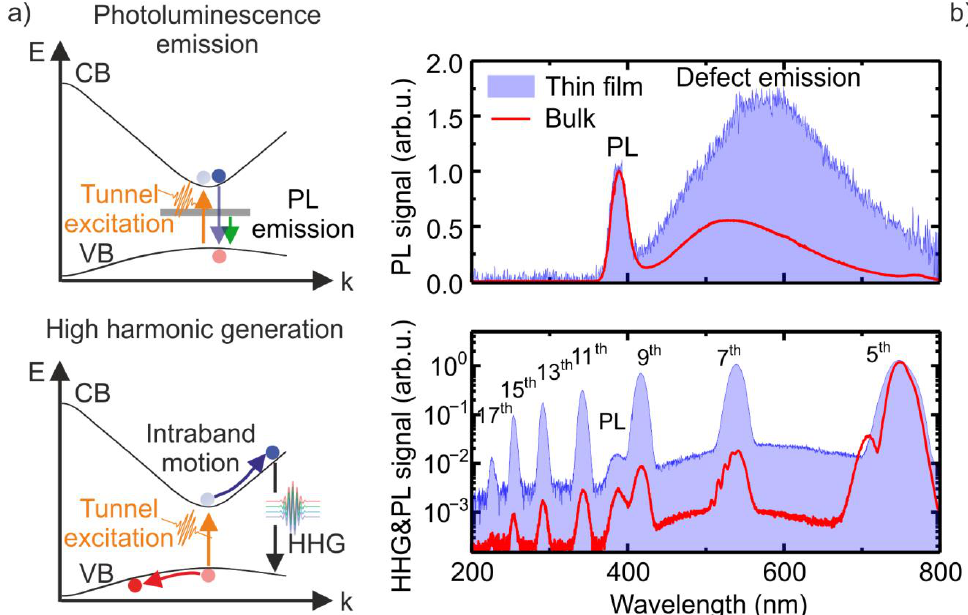
Figure 1. Photoluminescence (PL), defect emission and high harmonic generation (HHG) in ZnO. ( a ) Schematic illustration of recombination processes upon strong field tunneling excitation of an electron-hole pair. Upper panel: PL and defect emission as a result of electron-hole recombination from conduction band (purple arrow) and defect states (green arrow). Lower panel: Harmonic radiation is generated by a field driven nonlinear intraband motion of the electron as well as electron-hole recombination. ( b ) Emission from a thin film and bulk sample irradiated with linear polarized femtosecond laser pulses with a central wavelength at 3.85 µm. Upper panel: Normalized photoluminescence and defect emission spectra from the thin film (blue) and bulk (red) sample. Lower panel: High harmonic spectrum, on top of the PL and defect emission, generated in a thin film (blue) and bulk sample (red).